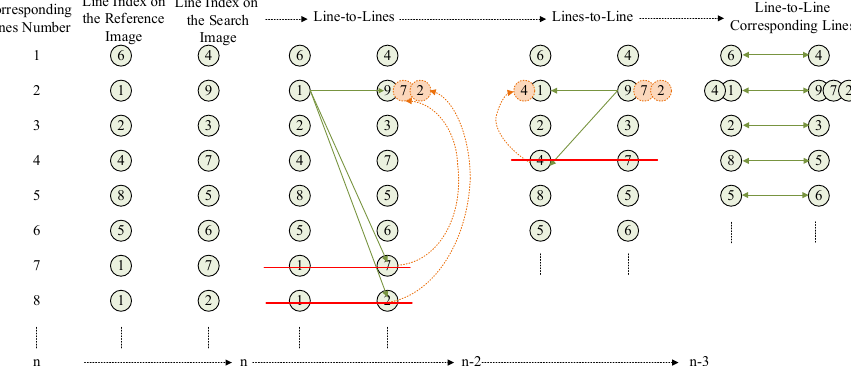
Figure 5. Checking and integrating of one-to-many and many-to-one line